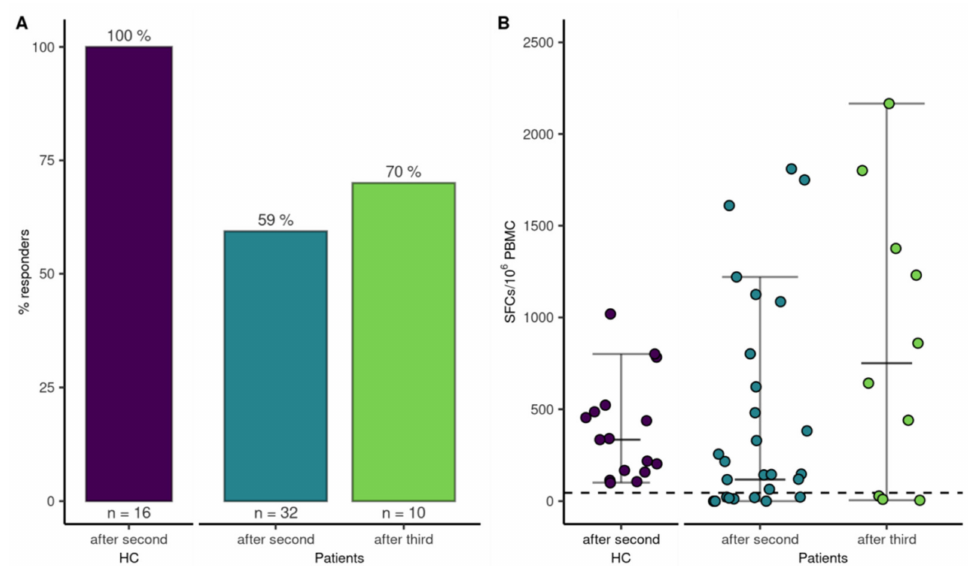
Figure 5. T-cell response to mRNA SARS-CoV-2 vaccination. ( A ) Bars indicate proportion of patients with a T-cell response after the second and third vaccination and HCs after the second vaccination. ( B ) Dots represent quantitative T-cell responses in HCs and patients two-four weeks after the second vaccination and in a subgroup of patients four weeks after the third vaccination.